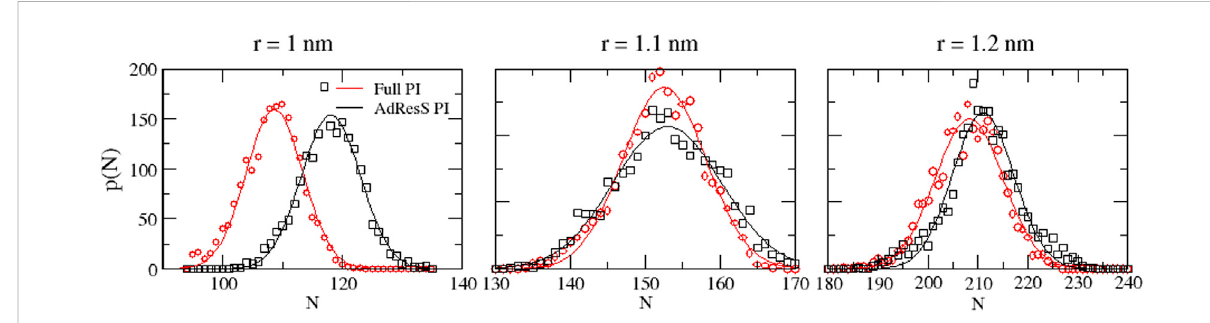
FIGURE 5 Particle number probability distributions calculated in the PI region and the equivalent subregion of the reference simulation.